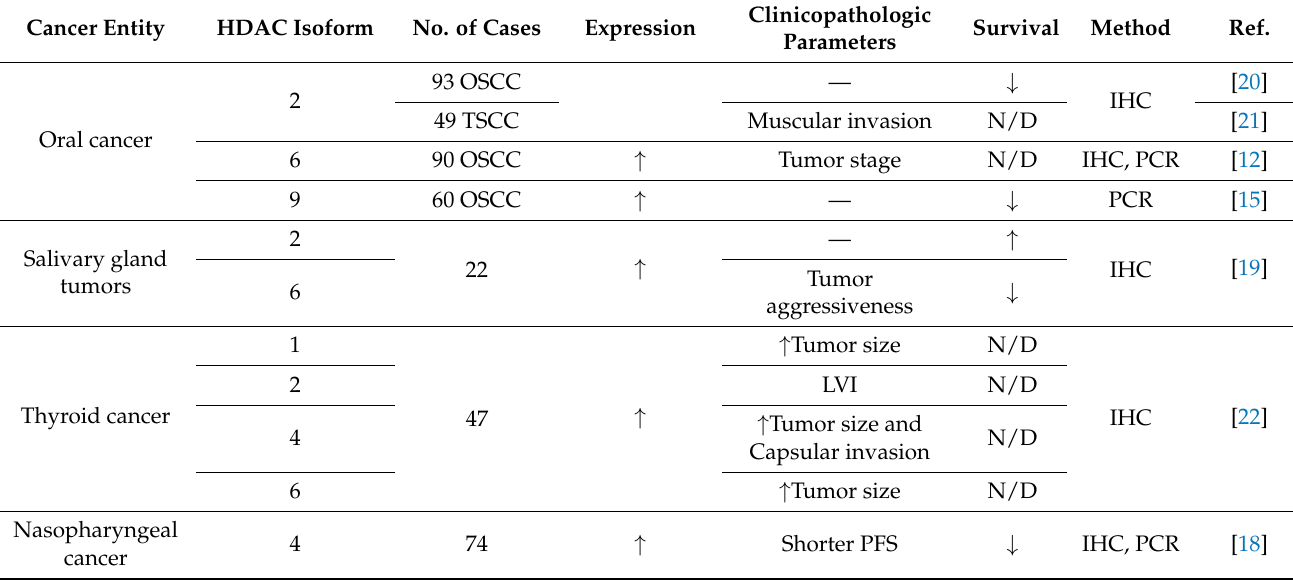
Table 2. Association of different HDAC isoforms expression in head and neck tumors and their correlation with clinico- pathological parameters and patients’